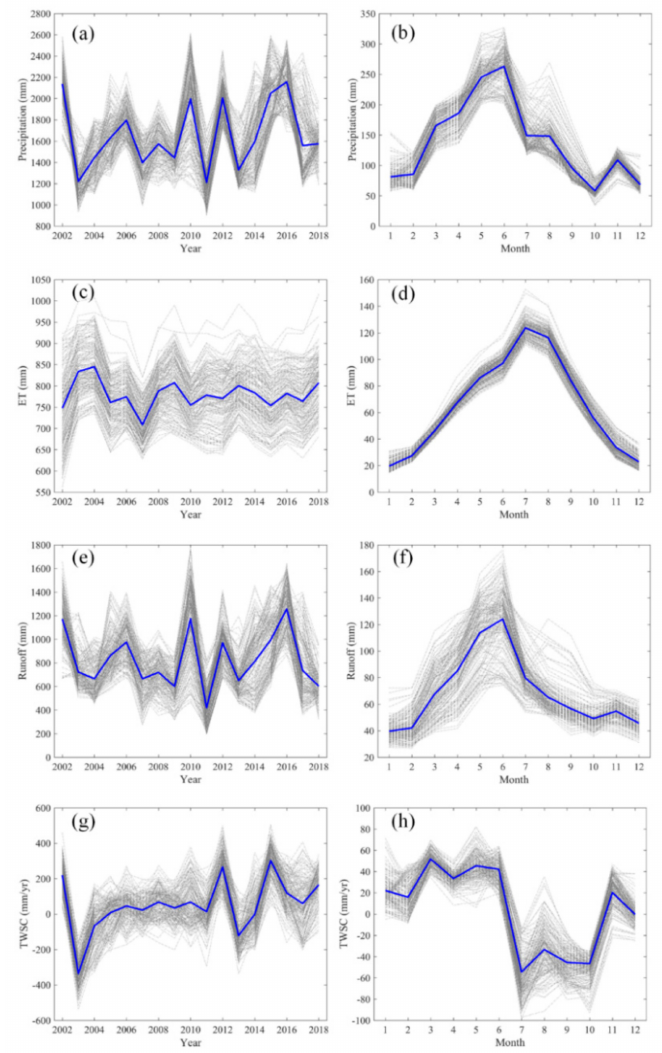
Figure 4. Annual and monthly mean ( a , b ) precipitation, ( c , d ) ET, ( e , f ) runoff, and ( g , h ) TWSC varia- tion in the 172 sub-basins from 2002 to 2018 (the blue line represents the average of the 172 sub-basins). The left panel shows annual results and the right panel shows monthly mean